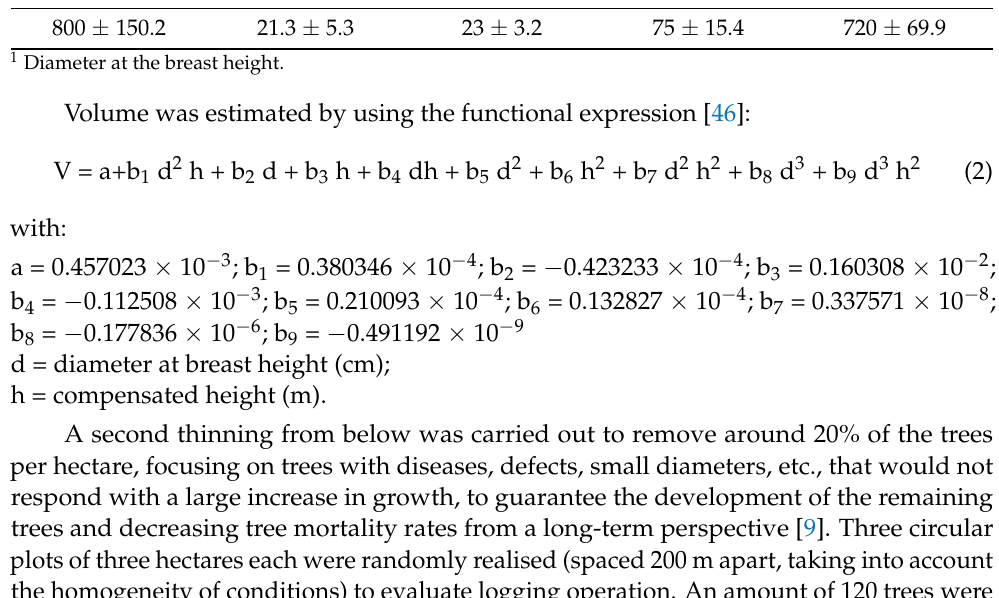
Table 1. Main characteristics of trees (means ± SD).